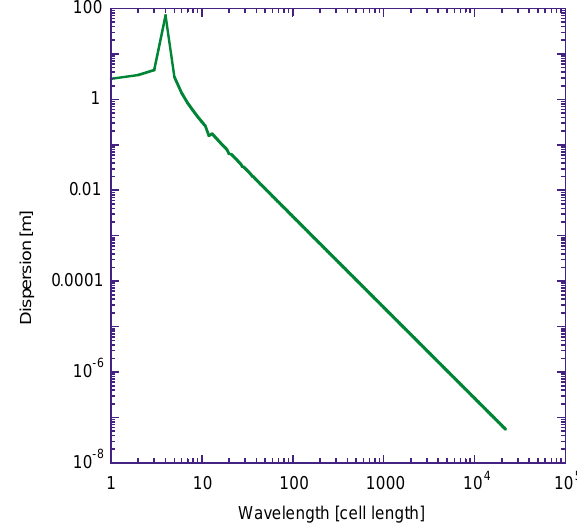
FIG. 8. (Color) Dispersion arising at the end of 100 90 ± FODO cells after steering to a periodic misalignment with a wavelength in units of the cell length. Note that the betatron wavelength in a 90 ± cell is equal to the length of four cells which is where the dispersion